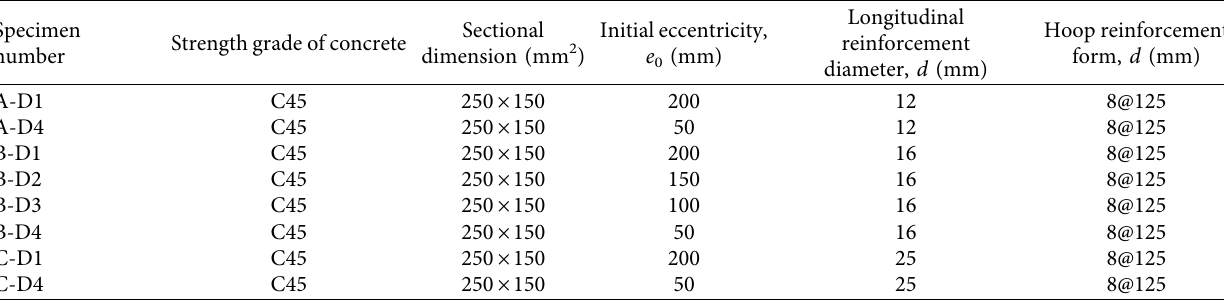
Figure 1: Schematic of specimen dimensions and reinforcement (mm). Table 1: Specimen design parameters.